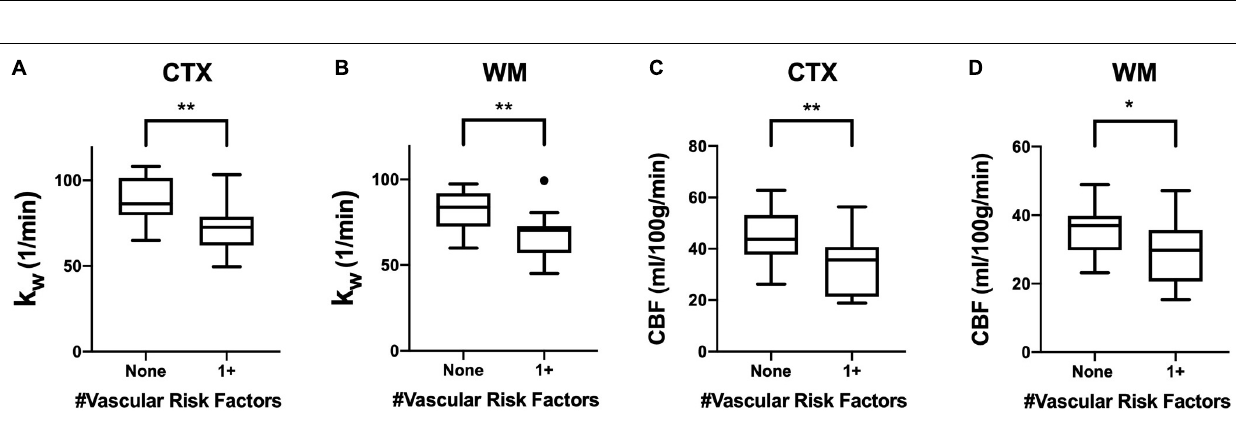
FIGURE 4 | Regional k W and CBF in the Context of Vascular Risk Factors. Tukey box plots showing (A,B) k W values and (C,D) CBF values were significantly higher in both the cerebral cortex (CTX) and cerebral white matter (CWM) in subjects without vascular risk factors (smoking, diabetes mellitus, or hypertension) ( n = 17) than those with at least one vascular risk factor ( n = 13). (** indicates p < 0.01, * indicates p < 0.05, non-parametric Mann-Whitney U